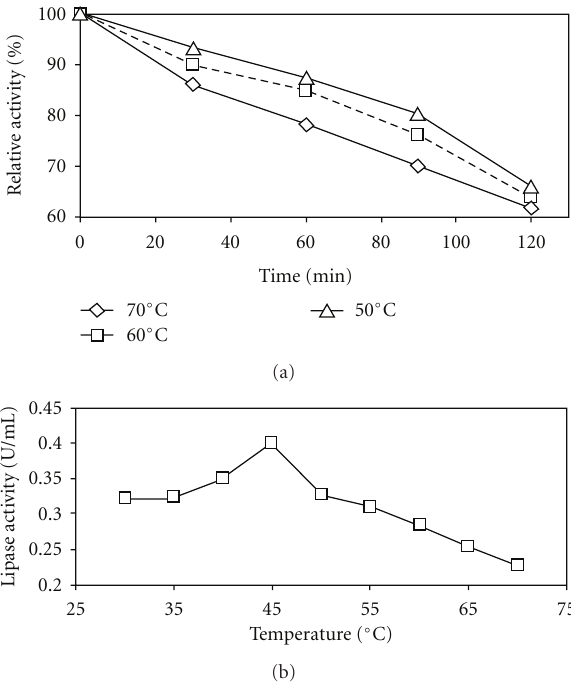
Figure 4: Acinetobacter sp. lipase thermostability (a) and e ff ect of temperature on its rate of olive oil hydrolysis (b).